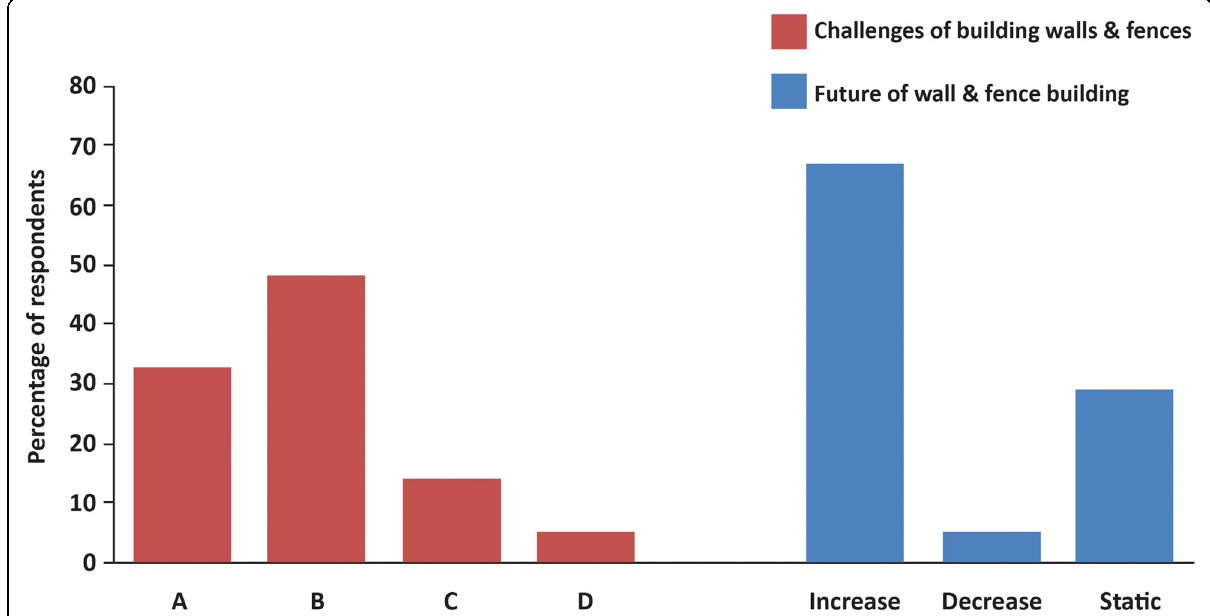
Figure 8 Perception on the challenges of building the walls and installation of the fences and its future. A Inadequate stones and poles. B Permit restrictions by forestry officials. C Lack of labour. D Do not